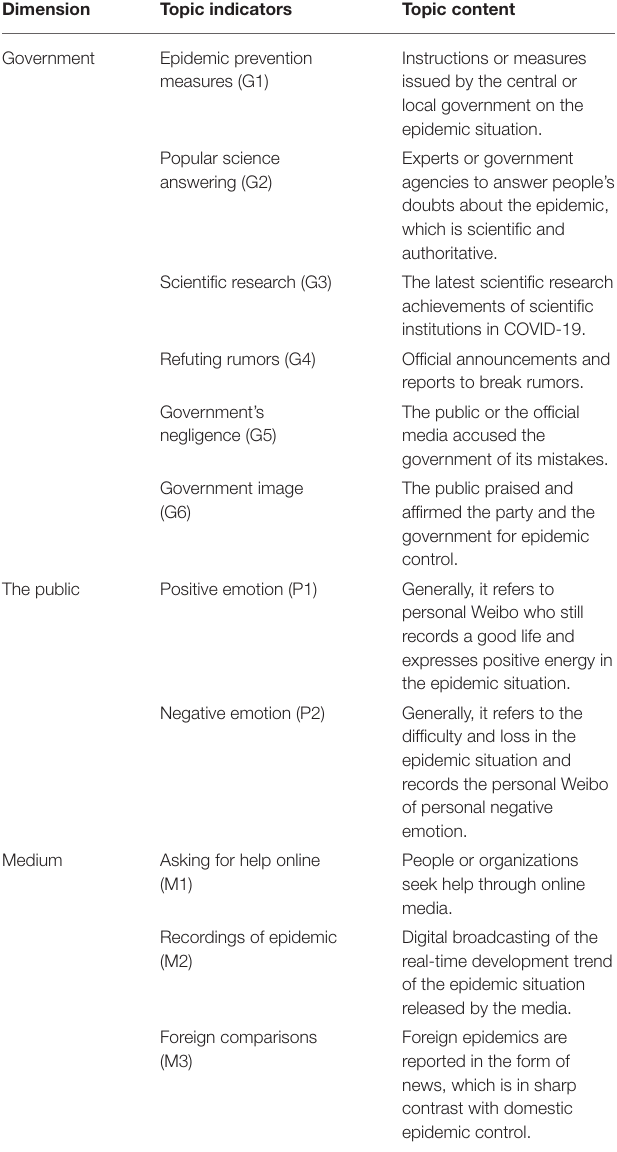
TABLE 1 | The key topic indicators of Weibo. Dimension Topic indicators Topic